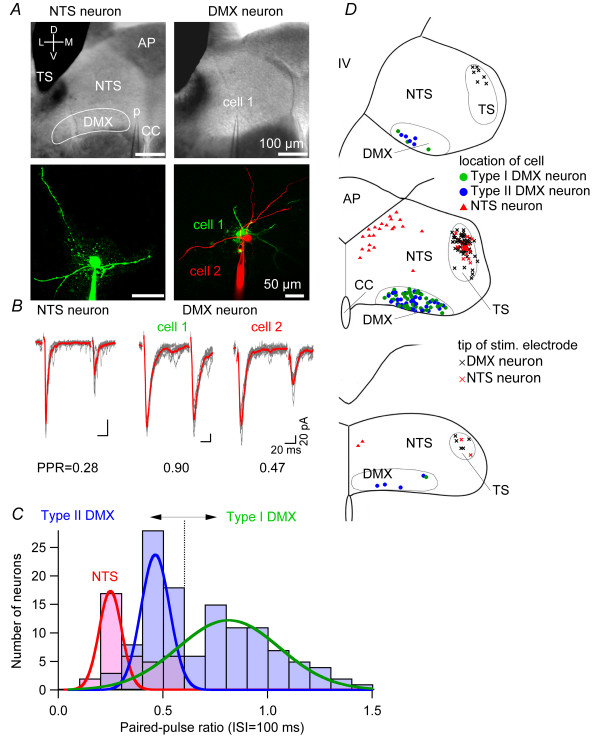
Analysis of paired-pulse ratio of the excitatory transmission from the TS to DVC neurons. A, above, IR-DIC photomicrographs indicating the location of the patch recording pipette (p) and the stimulation electrode in the DVC. Left, recording from a dm-cNTS (NTS) neuron; right, recording from a DMX neuron (designated as "cell 1"). Bottom, confocal microscopic images of a dm-cNTS neuron that is visualized with injected Alexa Fluor 488 (left) and two DMX neurons (cell 1, visualized with Alexa Fluor 488 and shown in green; cell 2, with Alexa Fluor 568 and shown in red). B, sample traces of the EPSC waveform evoked by TS stimulation. Gray traces show the eight overlaid traces of consecutive responses and the red traces show their average. Left, responses of the dm-cNTS neuron shown in (A); right, responses of adjacent DMX neurons shown in A (cell 1 and cell 2). The values on the bottom show the PPR calculated for these three neurons. C, a histogram showing the distribution of PPR of the DMX and dm-cNTS neurons. Bars in light red show the PPR for dm-cNTS neurons (n = 35) and those in light blue show the PPR for DMX neurons (n = 120). Note a trough of the histogram around PPR = 0.6, which is the threshold used to classify the DMX neurons into type I (PPR > 0.6) and type II (PPR < 0.6). All dm-cNTS neurons showed PPR < 0.6. Curves in red, blue and green show the best-fit Gaussian distributions representing the histogram peaks for dm-cNTS, type II DMX and type I DMX neurons, respectively. D, schematic drawings of the distribution and localization of the soma of recorded neurons (33 dm-cNTS, red triangles; 56 type I DMX, green circles; 52 type II DMX, blue circles) and the tip of stimulus electrodes (black crosses, for DMX neuron responses; red crosses, for dm-cNTS neuron responses), plotted on three representative coronal slices (from top to bottom, rostral to caudal).